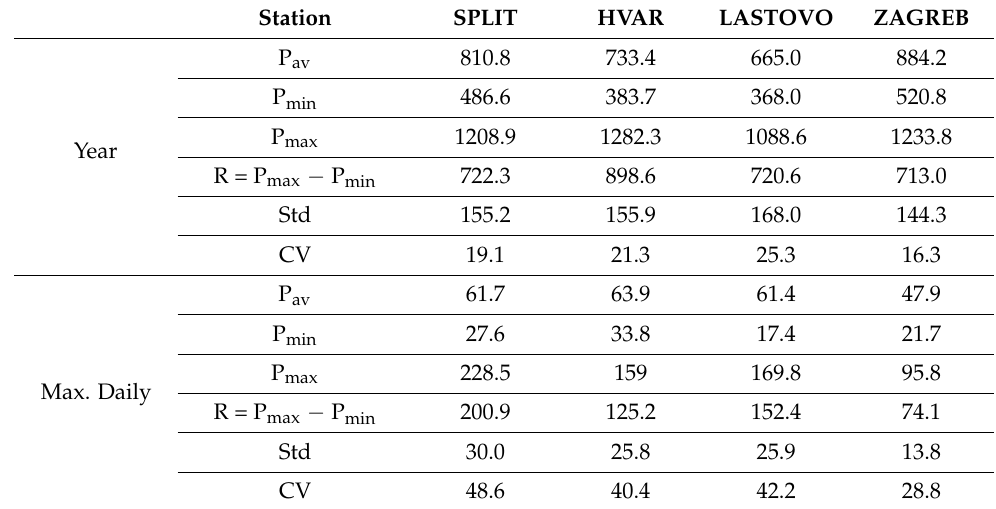
Table 2. Matrix of characteristic values, average, Pav (mm), minimum, Pmin, maximum, Pmax, range, R, annual and maximum annual daily time series standard deviation, Std, a coefficient of variation, CV, at four analysed stations.